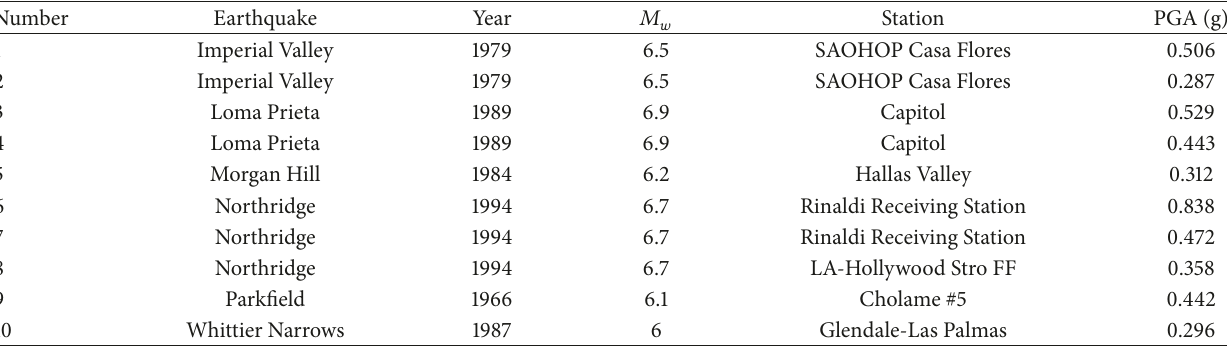
Table 2: Ground motion database.